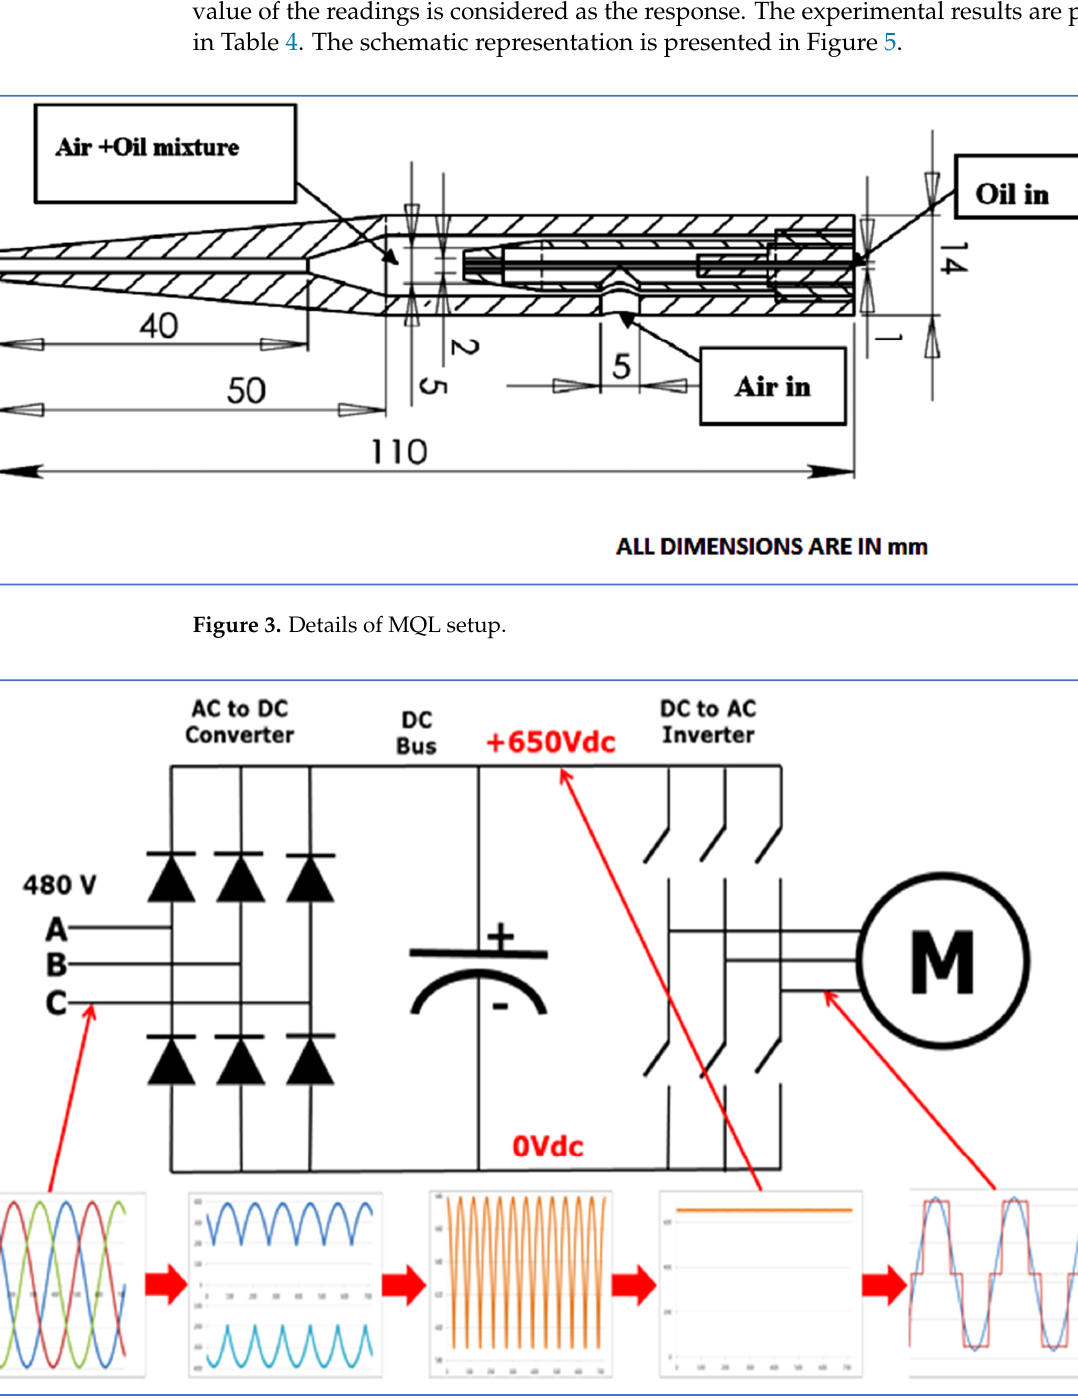
Figure 4. Circuit diagram of VFD setup.